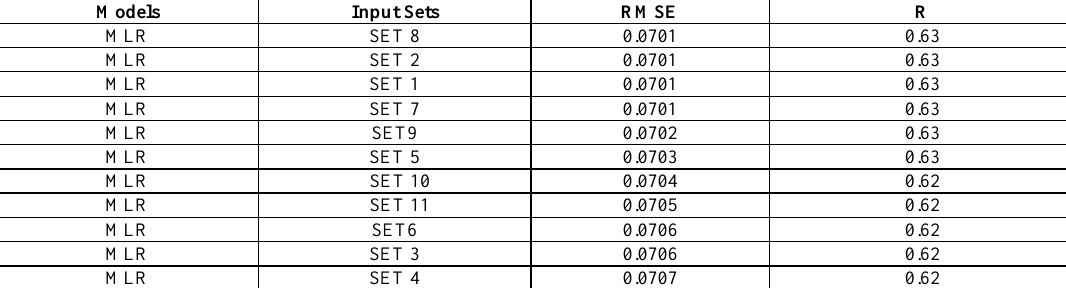
Table 5. Comparison of MLR input sets